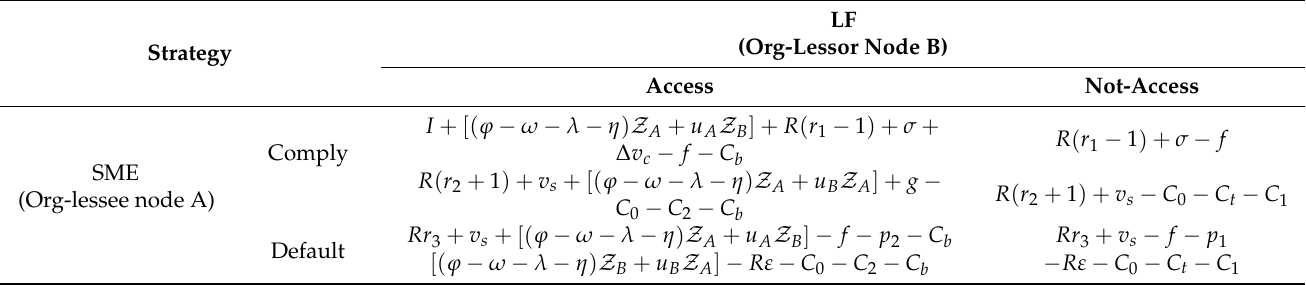
Table 2. Evolutionary game payoff matrix of the SME and